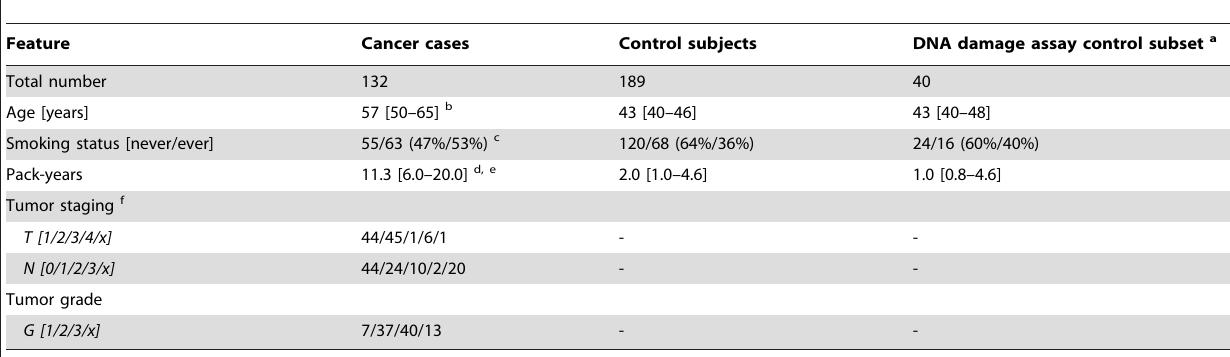
Table 1. Characteristics of the groups of subjects involved in the